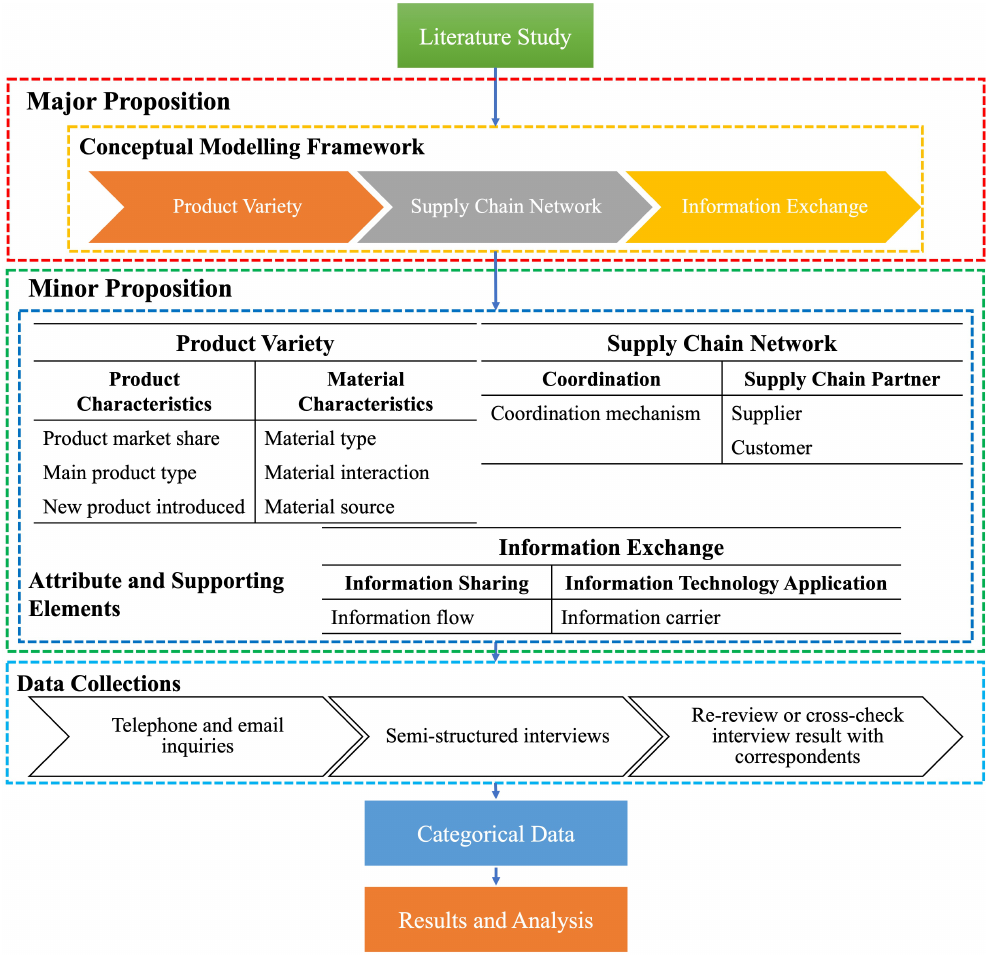
Figure 1. This is the process of our case study in multiple industry applications to examine our propositions and reach a well-informed conclusion. Our major propositions start with our literature study [67] to identify the current issue and end with designing the conceptual modeling framework of product variety, supply chain network, and information exchange. Then, our minor proposition is to break each domain down into the attributes and elements to support our interview